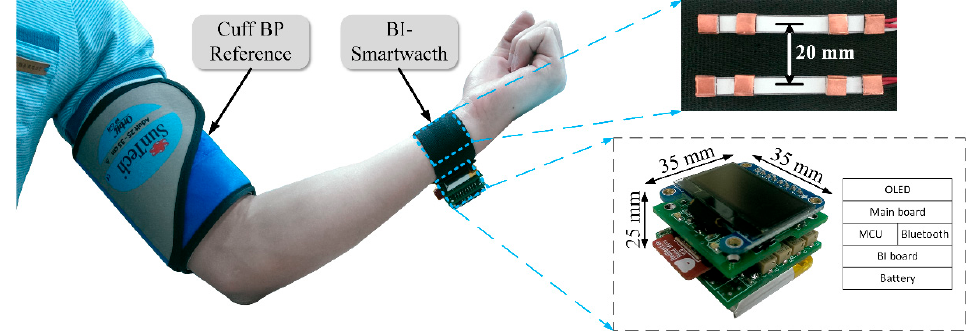
Figure 12. Prototype of the designed PWV-based BP smartwatch at the wrist with the BP standard device located on the upper arm.